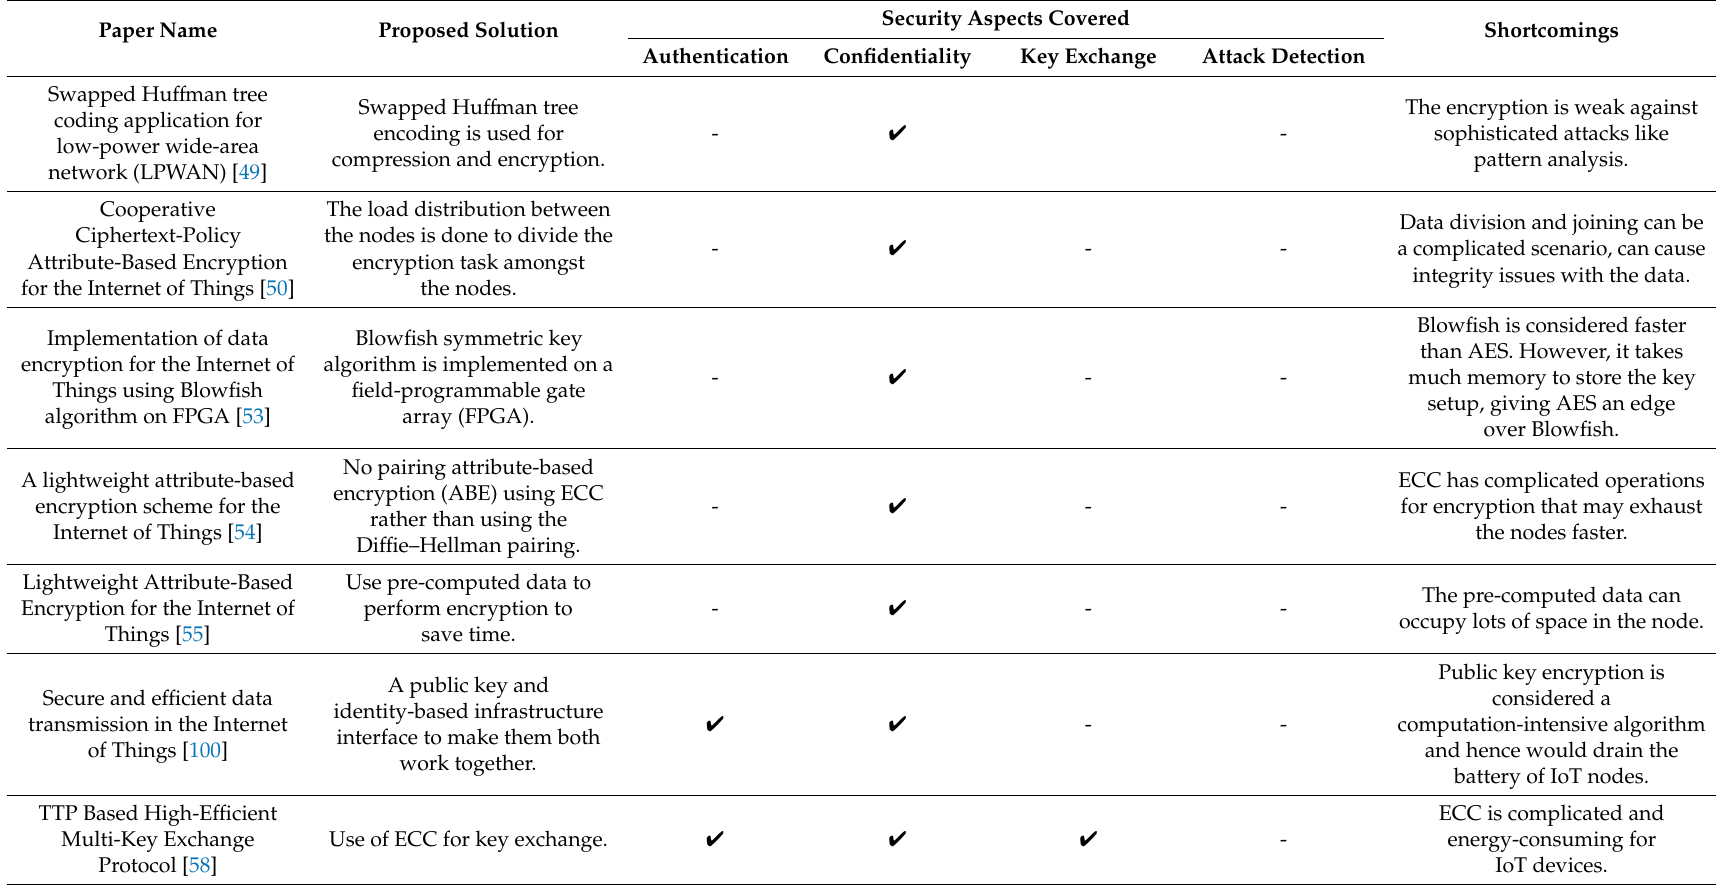
Table 3. Comparative analysis of existing security